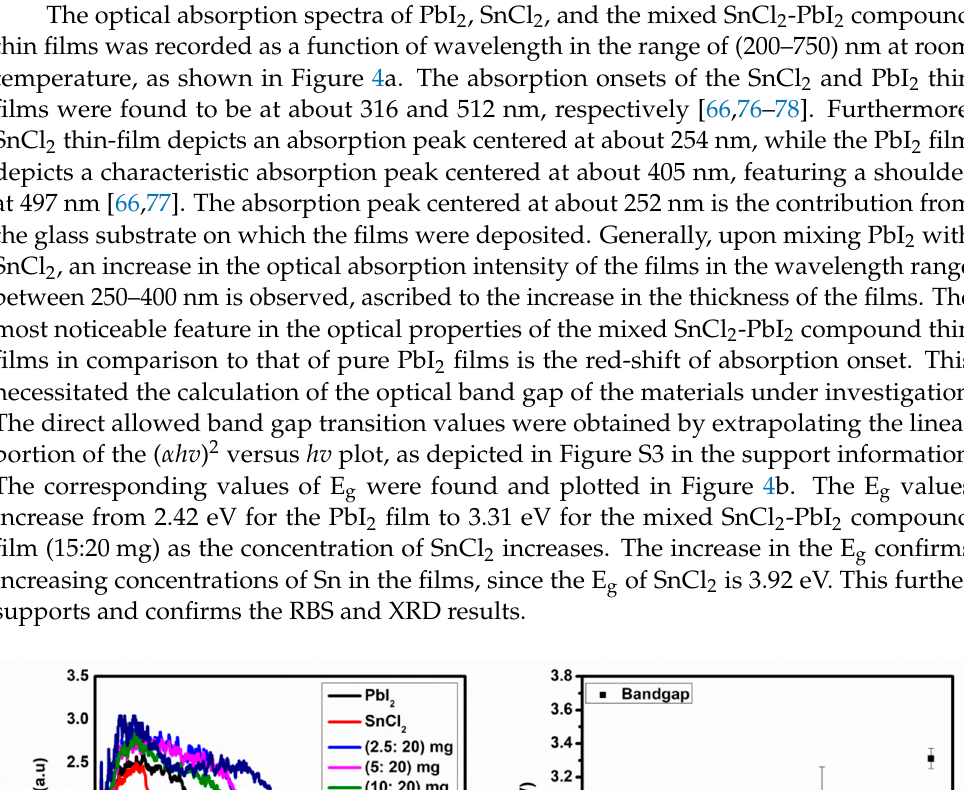
Figure 3. ( a ) X-ray diffraction pattern of PbI 2 , SnCl 2 and mixed SnCl 2 -PbI 2 compound film, ( b ) is the zoom-in to the (001) and (222) peaks.